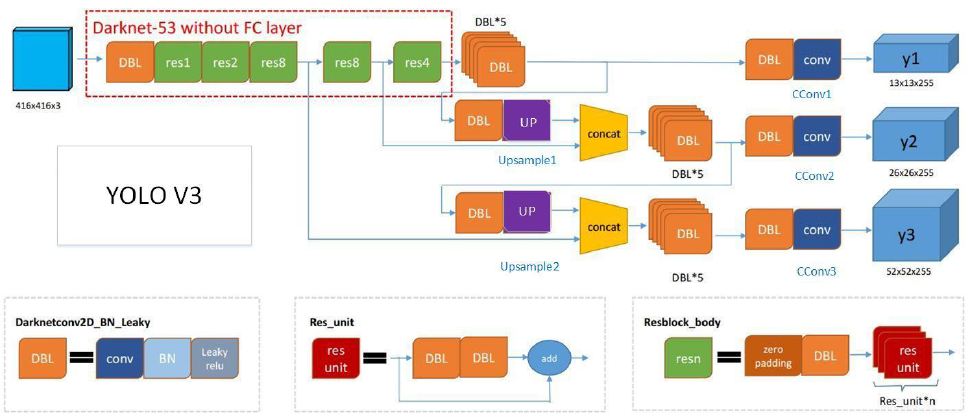
Figure 13. YOLO V3 network structure.